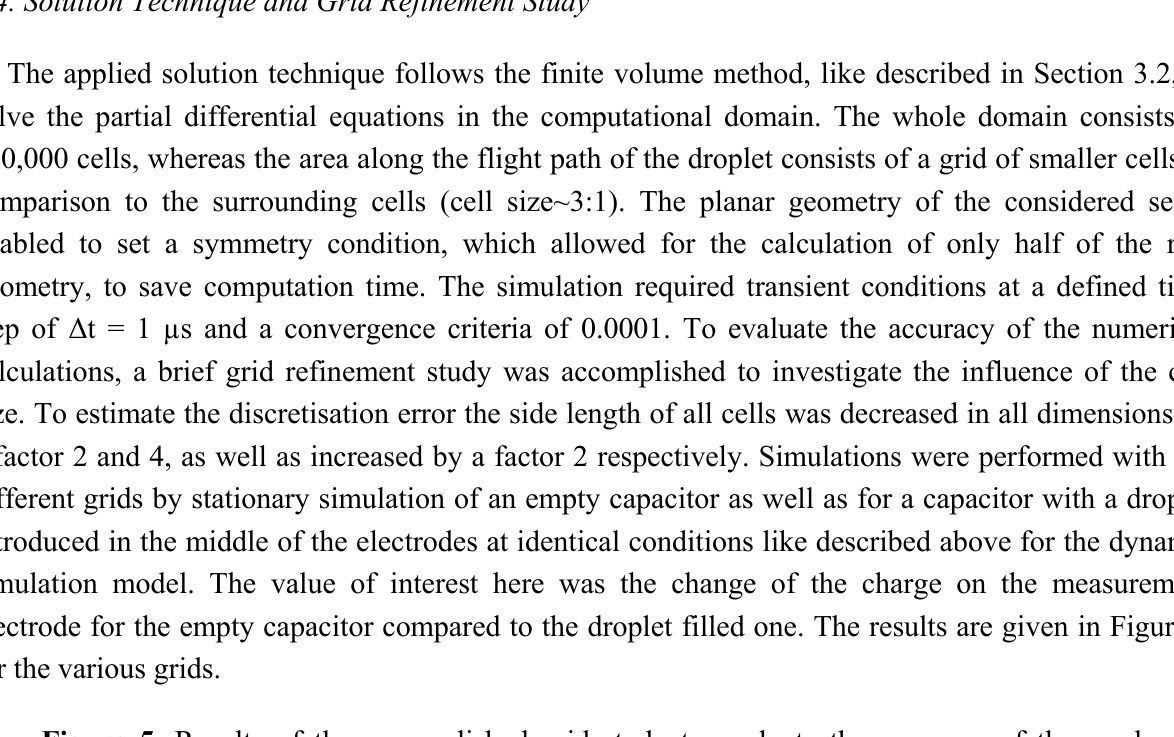
Figure 5. Results of the accomplished grid study to evaluate the accuracy of the used computational